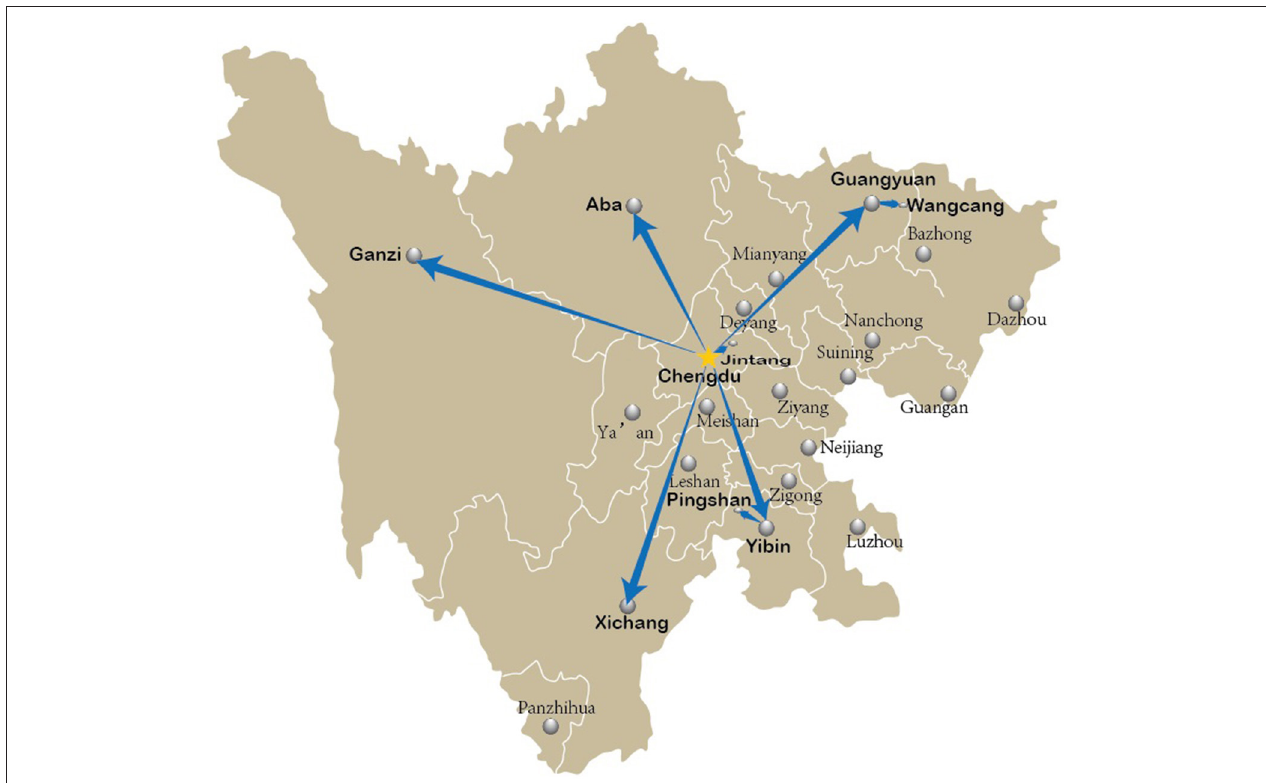
FIGURE 1 | The pilot Telestroke and Telethrombolysis Network of Sichuan Province, China. West China Hospital of Sichuan University in Chengdu, the provincial capital, was designated as the hub center (golden star), and the network currently covers nine spoke hospitals (in boldface; two institutions in Pingshan, and one in each other region) around Sichuan.